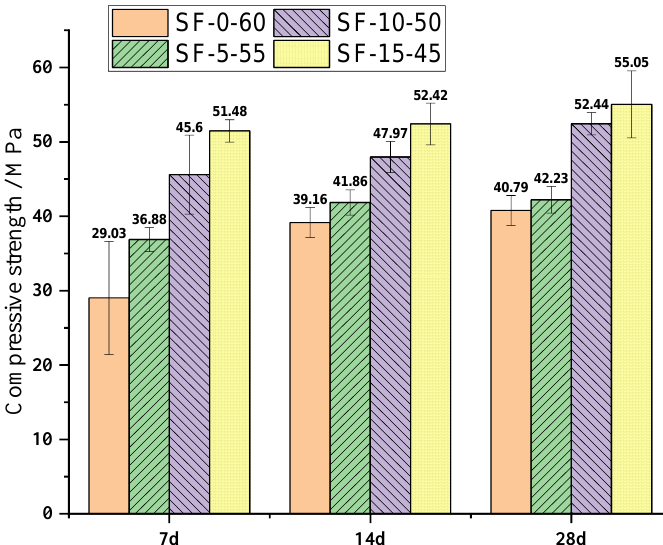
Figure 4. Compressive strength of slag/fly-ash-based ECCs at different curing